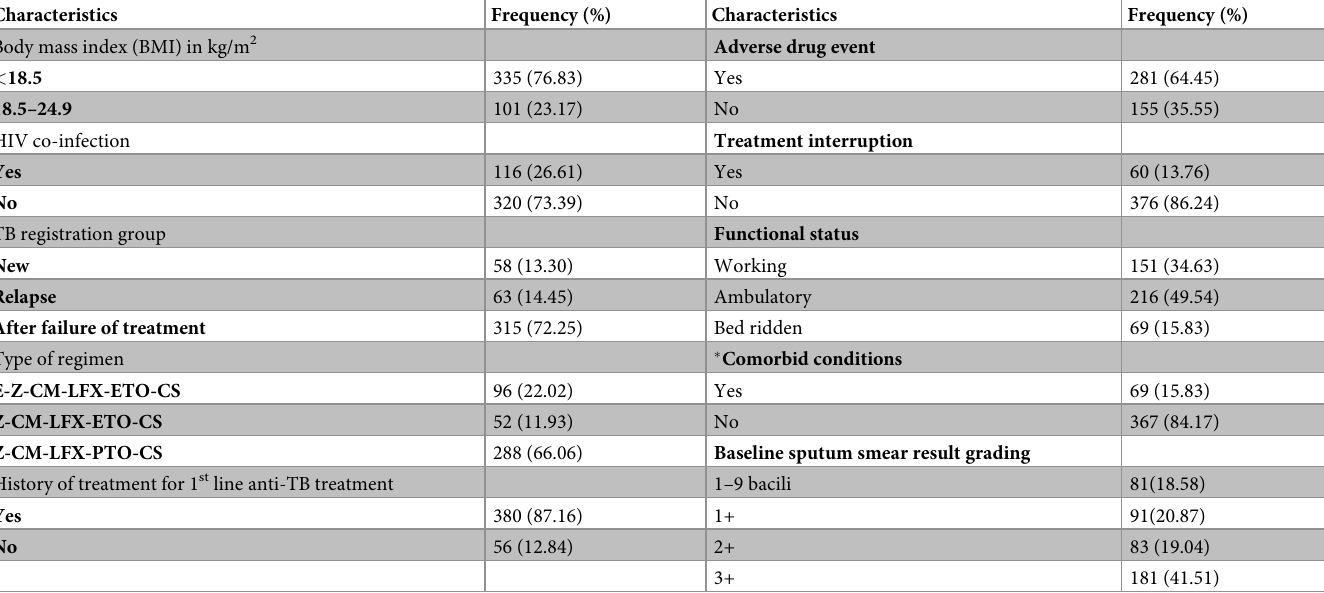
Table 2. Clinical characteristics of patients and treatment related factors among DR-TB patients in North West Ethiopia (N = 436).